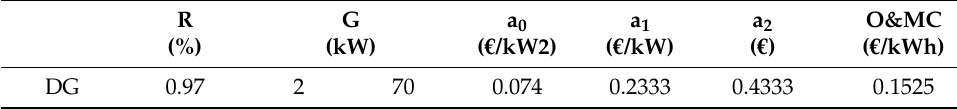
Table 4. Power limits and cost coefficients of diesel generator [30].